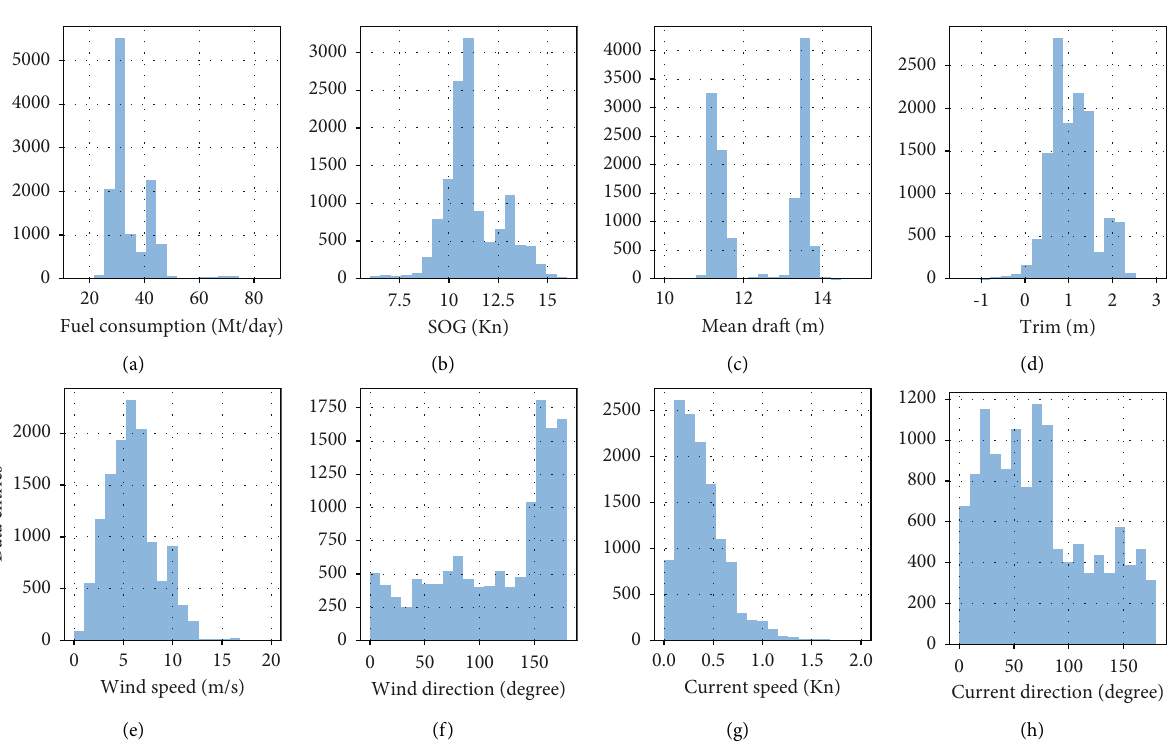
Figure 2: Distribution of each